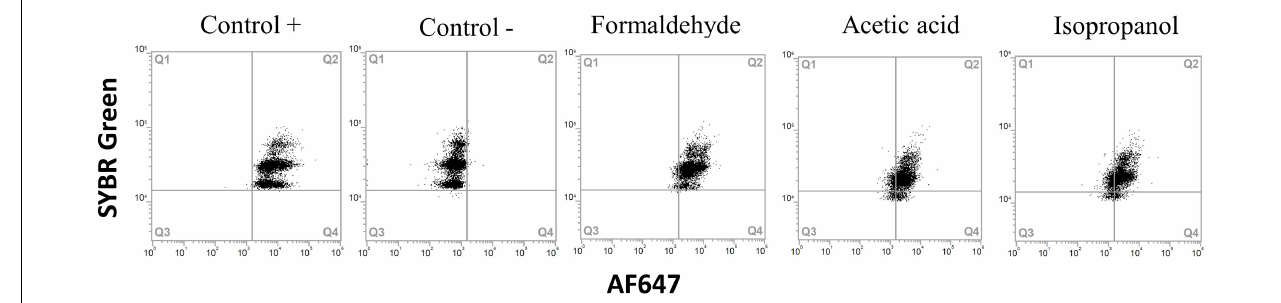
FIGURE 6 | Flow cytometry dot plots of Yersinia ruckeri. Cells were treated with acetic acid 7%, 70% isopropanol and fixation with formaldehyde to obtain dead populations. Positive and negative HPG controls were carried out for comparison. All treatments presented a positive protein synthesis activity.